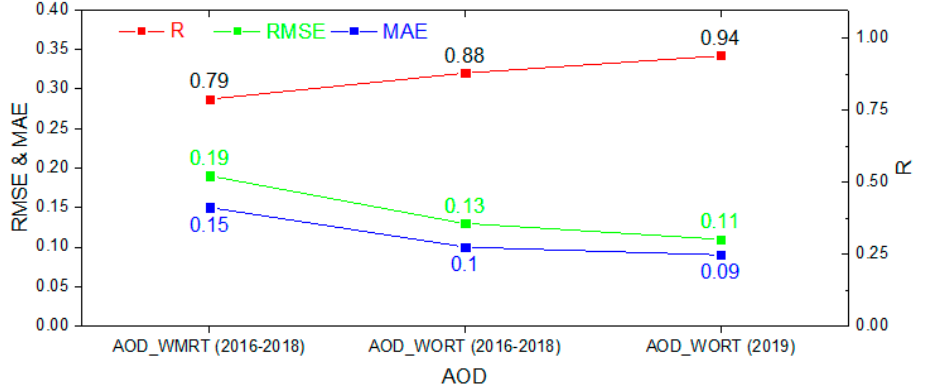
Figure 14. Error statistics (RMSE and MAE) and correlation coefficient (R) for AOD_WMRT (2016– 2018), AOD_WORT (2016–2018), and AOD_WORT (2019), respectively.